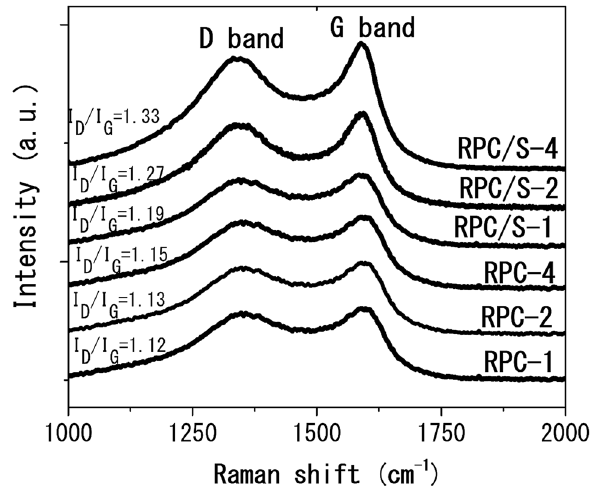
Fig. 2 Raman spectra of RPC and RPC/S